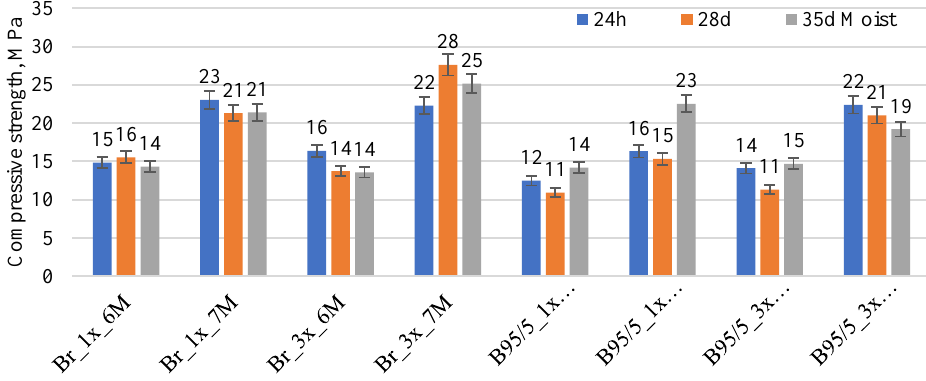
Figure 8. Compressive strength of AAM based on different red brick waste